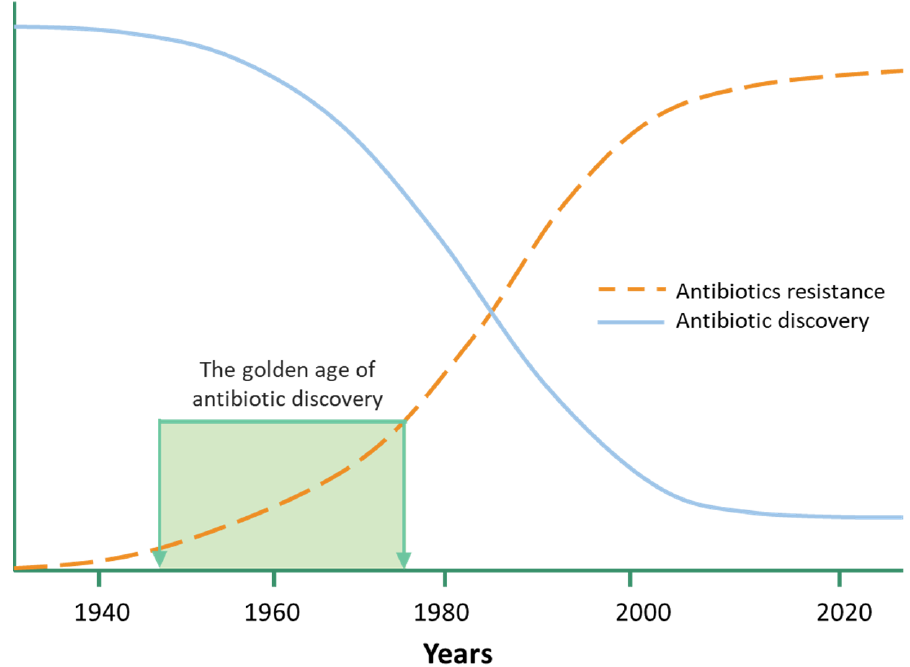
Figure 1. Discovery of antibiotics vs. development of resistance. The golden age for the discovery of antibiotics was between 1945–1975. After that, the discovery of antibiotics began to decline significantly. The main reason behind this is the increase in the development of antibiotic resistance in most pathogens, making the drugs ineffective against infections caused by MDR bacteria.